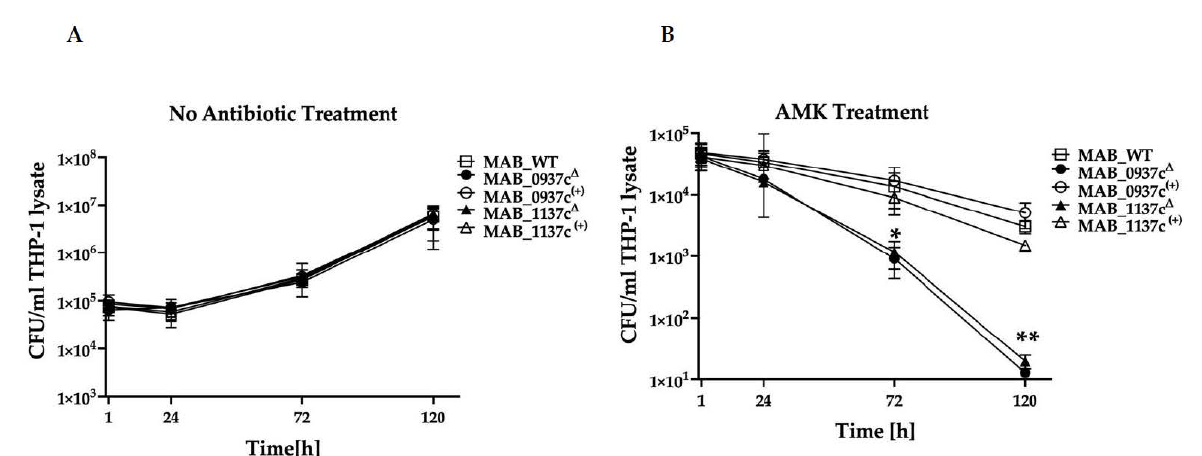
Figure 5. The improved antibiotic efficacy against infections of MAB efflux pump-deficient mutants in THP-1 macrophages. ( A ) The intracellular growth dynamics of MAB_0937c ∆ and MAB_1137c ∆ gene knockout mutants and MAB_0937c (+) and MAB_1137c (+) complemented clones without AMK treatment in comparison to the wild-type MAB 19977 were recorded with CFU/mL counts over 5 days of infection and by lysing THP-1 cells at the 1-h, 24-h, 72-h, and 120-h time points. ( B ) Intracellular survival rates of gene knockout and complemented clones during AMK treatment measured with viable bacterial CFU counts at 1 h, 24 h, 72 h, and 120 h post-infection. Data represent the mean ± SD of two independent experiments, each completed in triplicate. * p < 0.05 and ** p < 0.01 between the complemented clone and mutant at the corresponding time